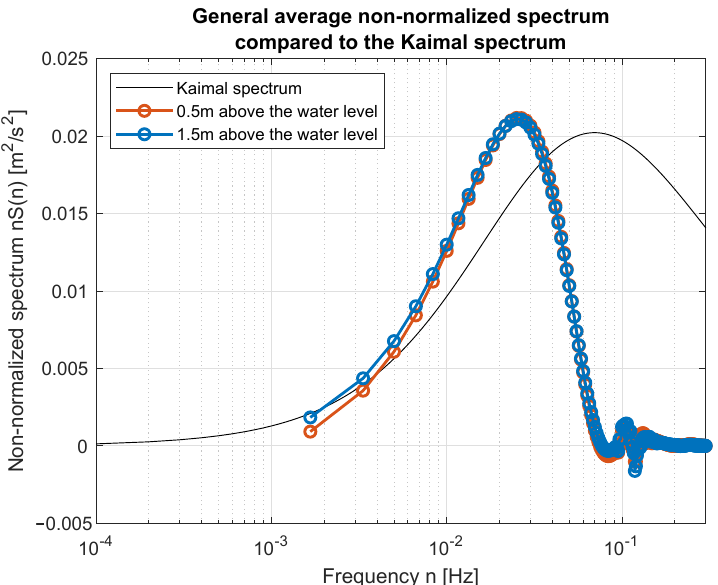
Figure 20. Weak wind (4 BFT in ship scale) compared to Kaimal spectrum.